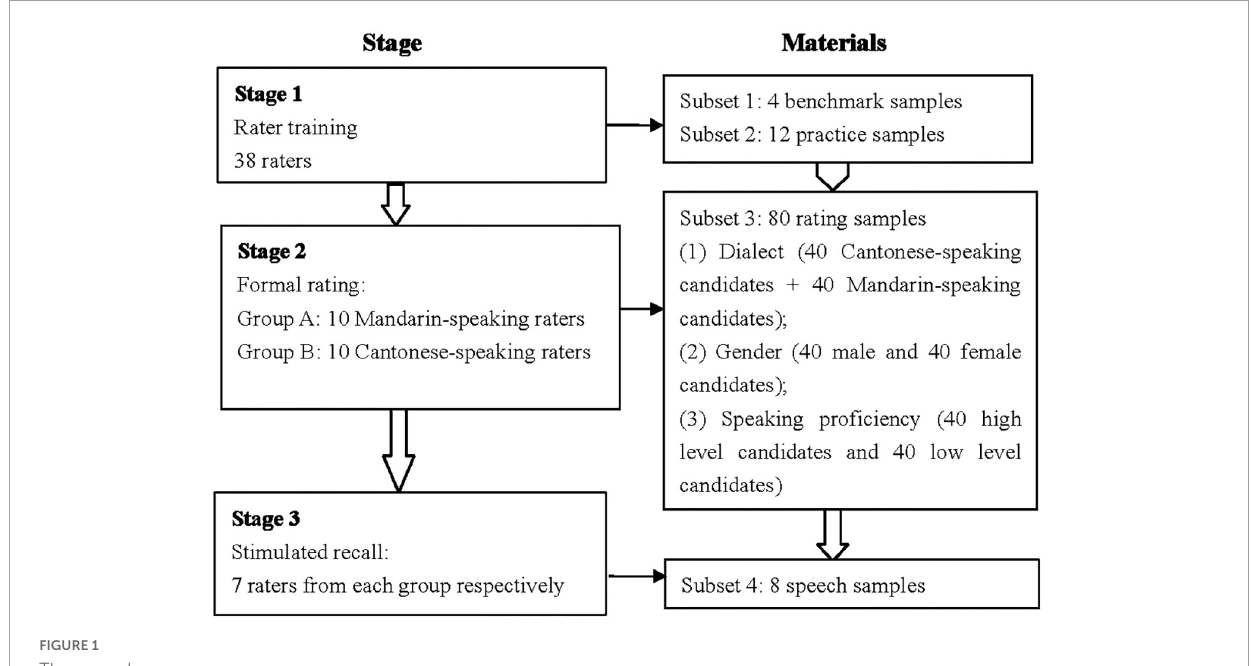
To answer RQ 1, raw data was collected by using Microsoft Excel spreadsheets. The interrater reliability statistics were calculated at first and the Two-Way factorial analysis of variance